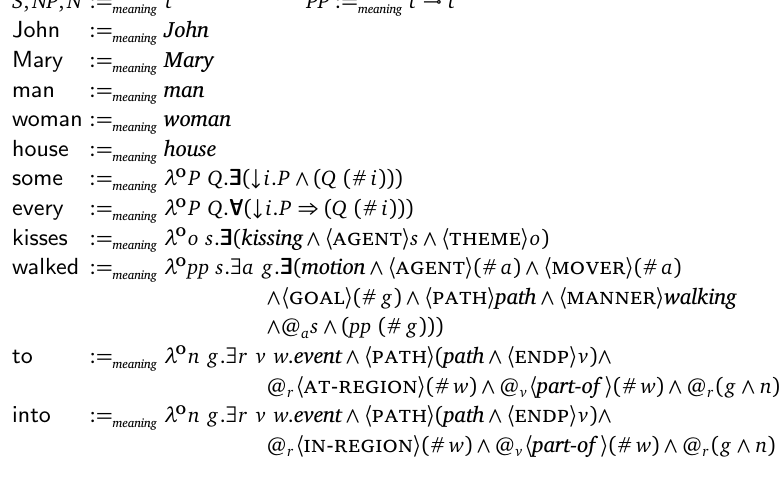
Semantic interpretation